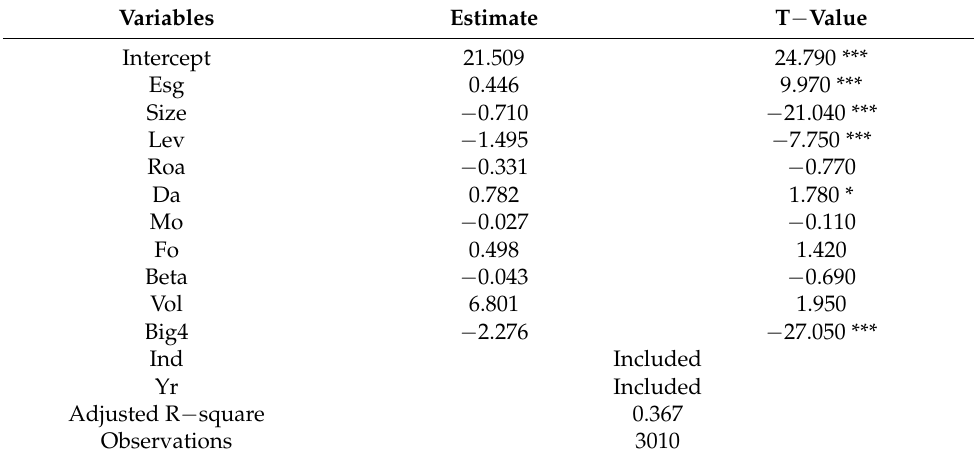
Table 4. The relationship between ESG and audit hours.